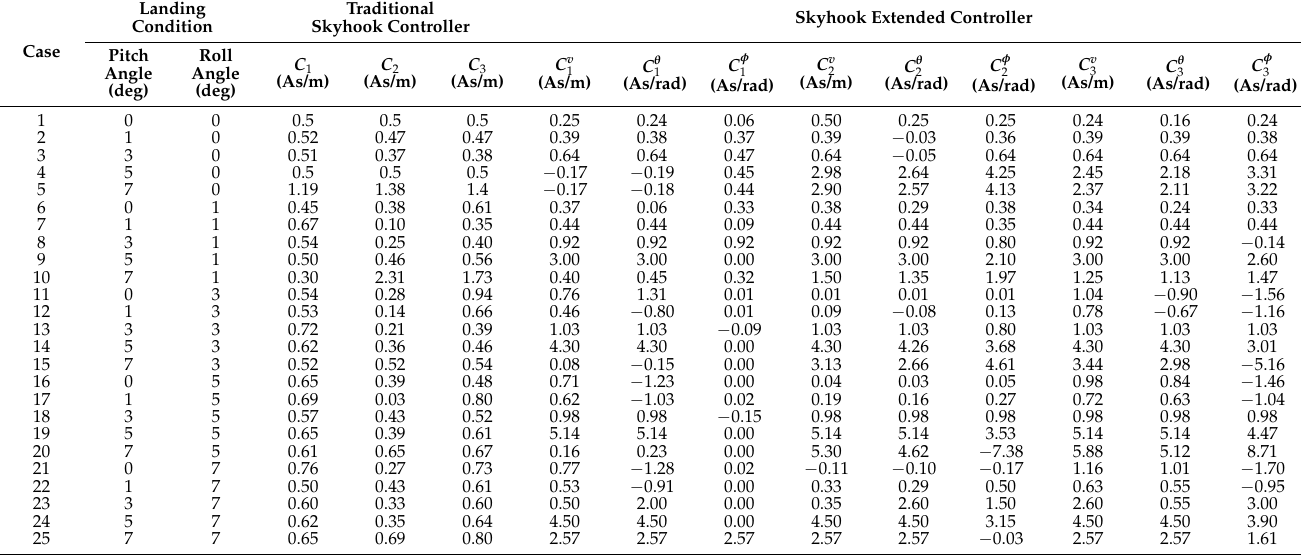
Table 2. Skyhook gain